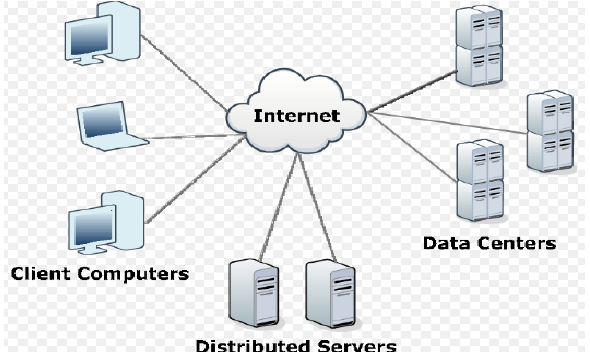
Figure 1 . Straightforward cloud computing